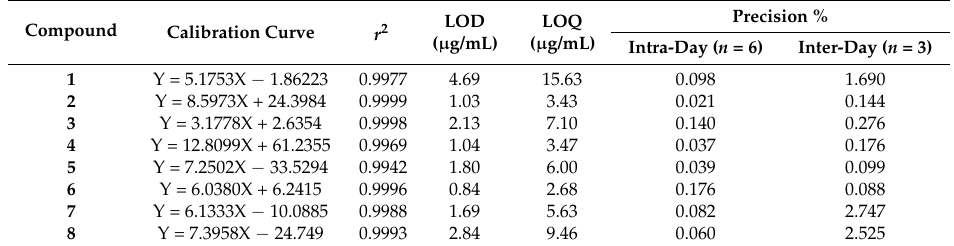
Table 1. Calibration curves, linearity, LOD, LOQ and precision of HPLC analysis for triterpenes 1 – 8 . Compound Calibration Curve